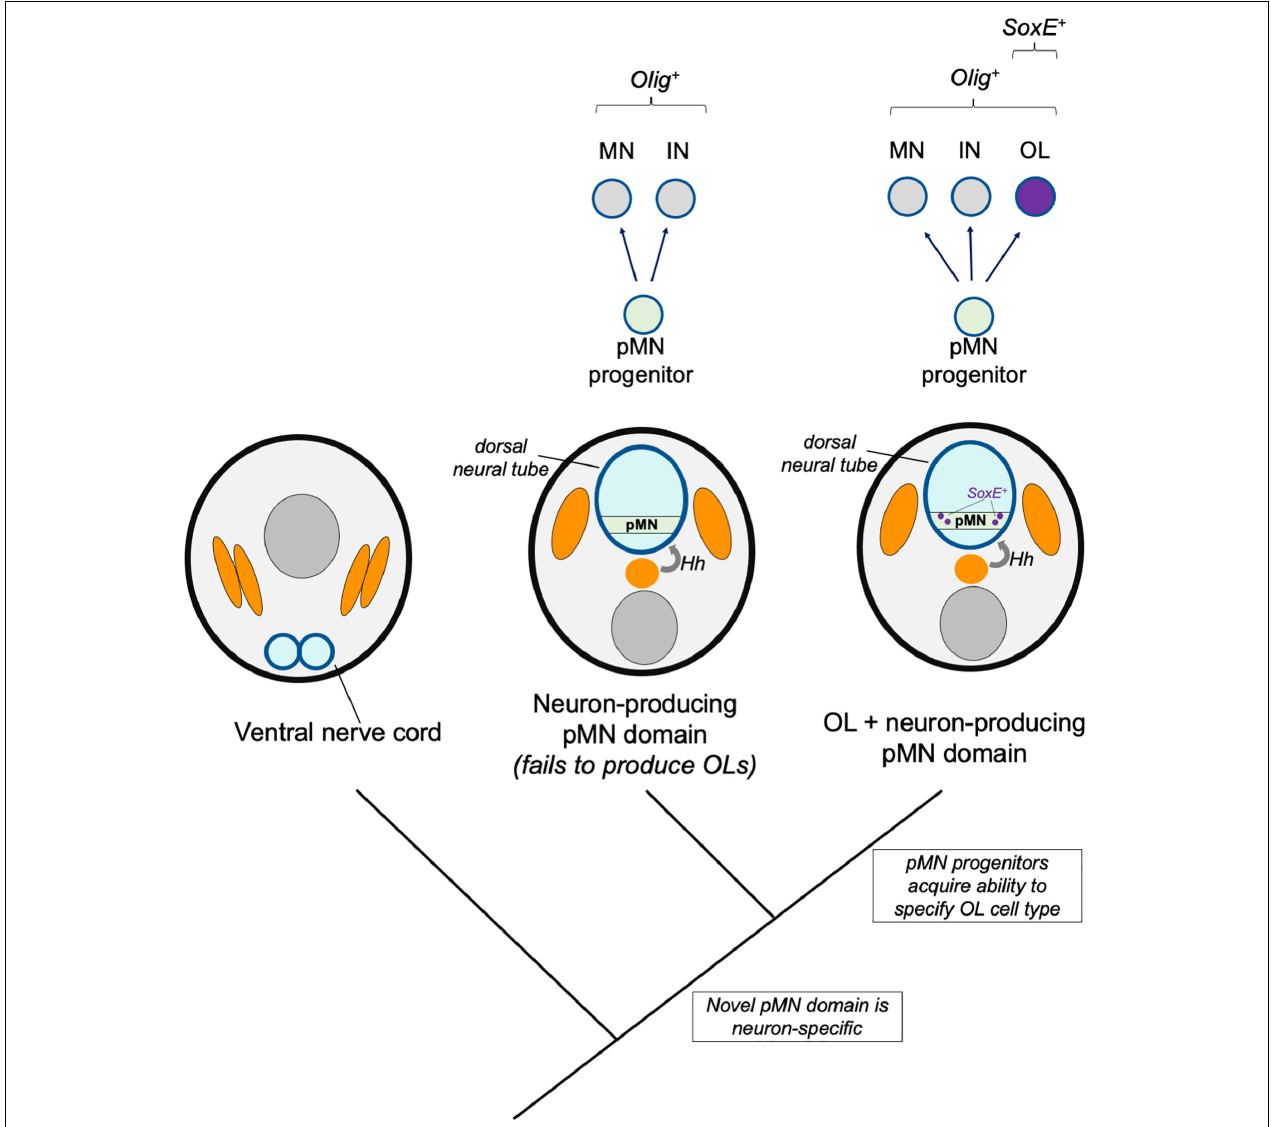
FIGURE 3 | Novel pMN derivatives model. A hypothetical model shows stepwise changes to neural induction and patterning. A primitive Hedgehog (Hh)-dependent neural tube patterning mechanism induced an Olig-expressing pMN domain (green) which initially produced motor neurons (MN) and interneurons (IN). Subsequent recruitment of SoxE expression to a subset of Olig-expressing progenitors was responsible for the origins of the oligodendrocyte cell type (OL,